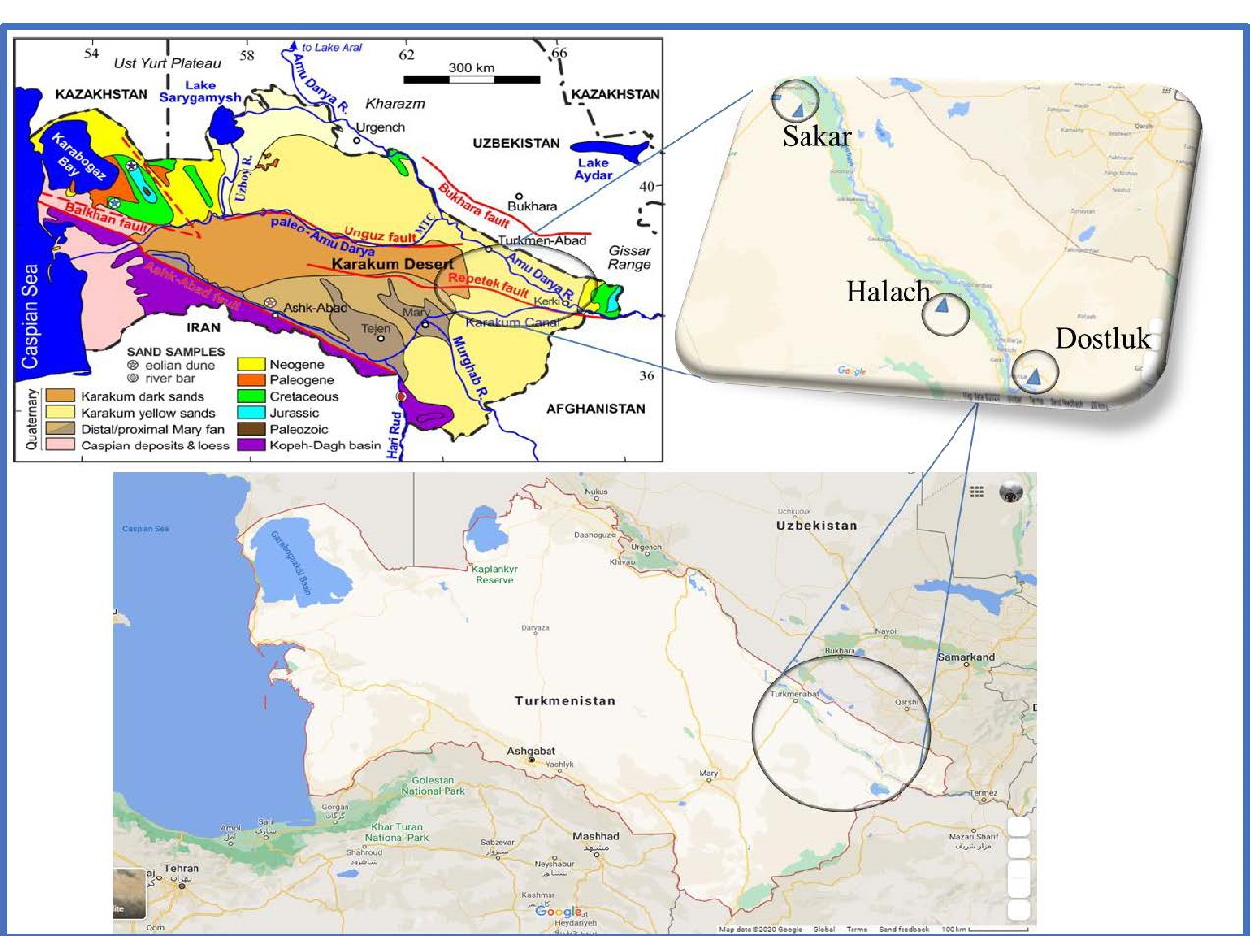
Figure A1. Location of Dostluk, Halach, and Sakar clays along the Amu-Darya River. The geological map image of Turkmenistan edited from the study [72].